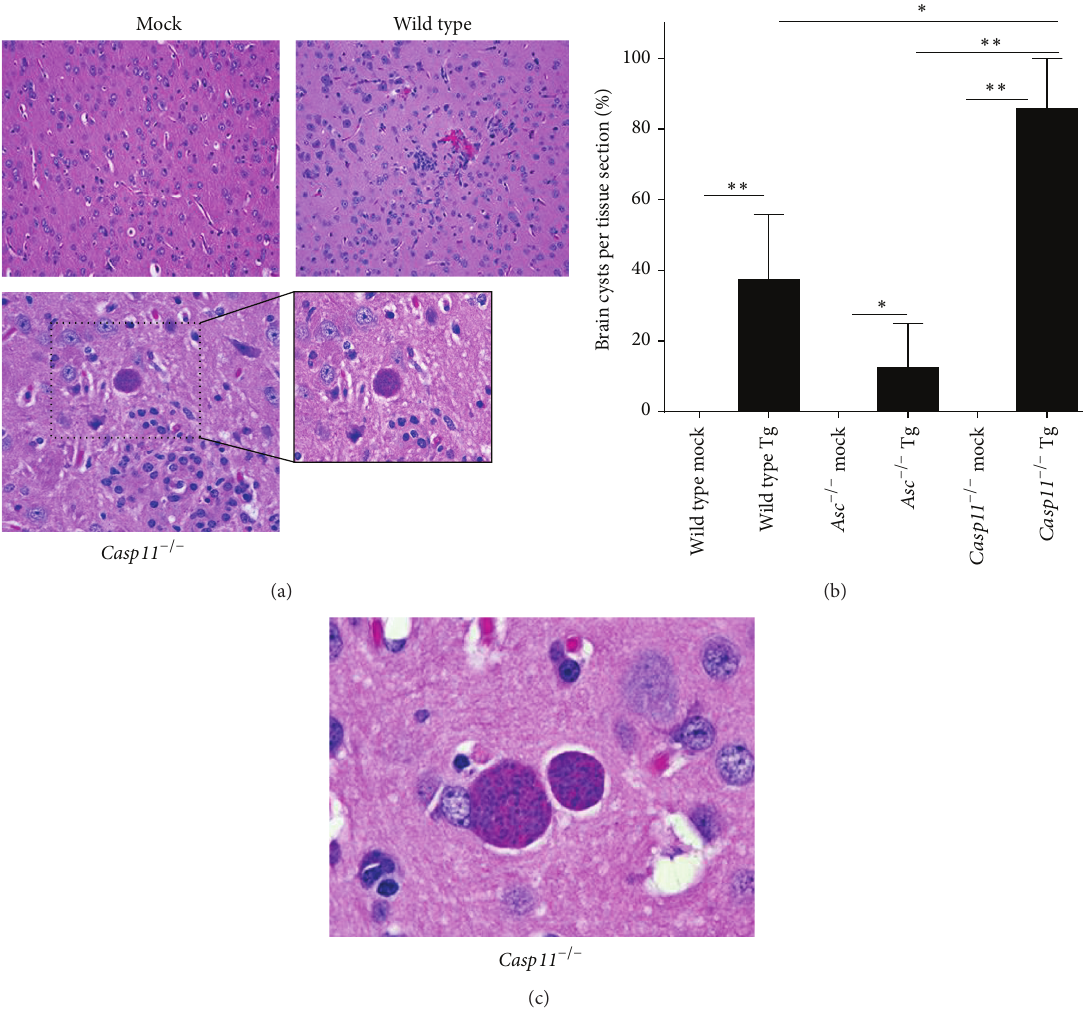
Figure 7: Toxoplasma gondii infection resulted in a greater brain tissue cyst burden in Casp11 −/− mice during the chronic phase of disease. Wild type, Casp11 −/− , and Asc −/− mice were infected with 1,000 Toxoplasma gondii Me49 tachyzoites via i.p. administration and brain tissue cyst formation was evaluated by histopathology 25 days after inoculation in surviving mice. (a) Histopathology assessments of H&E stained sections revealed tissue cyst formation in the brains from all genotypes infected with T. gondii . 20x magnification, 40x insert. (b) The presence of tissue cysts with the brain was assessed for each animal and the percent of animals with tissue cysts was determined. (c) High magnification image of a brain tissue cyst from a Casp11 −/− mouse. 100x magnification. ∗ 𝑝 < 0.05 ; ∗∗ 𝑝 < 0.01 . For all mock treated animals, 𝑛 = 3 . For all T. gondii inoculated animals, 𝑛 = 7 . Data shown are representative of 2 independent